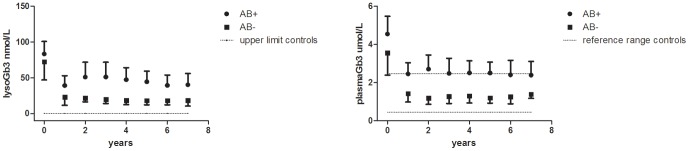
Plasma lysoGb3 and Gb3 in Fabry males.LysoGb3 (A) and plasma Gb3 (B) in 23 classic Fabry males, treated for at least one year (AB+ group n = 12, AB− group n = 11), depicting mean and 95% confidence intervals.